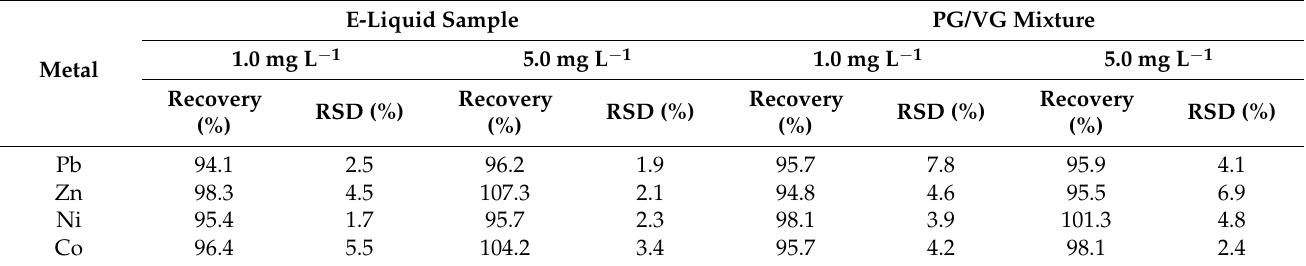
Table 3. The average recovery (%) and RSD (%) of spiked